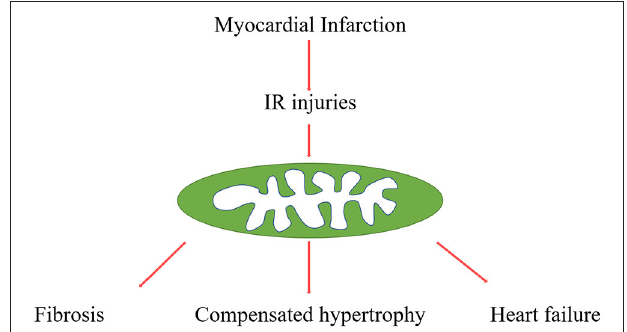
FIGURE 1 | Procedures from myocardial infarction to post-infarction remodelling. Myocardial infarction and reperfusion attributed mitochondria damage, mitochondria function, and structure disorders are involved in various pathophysiological processes, such as cardiac fibrosis, compensated hypertrophy, and final heart